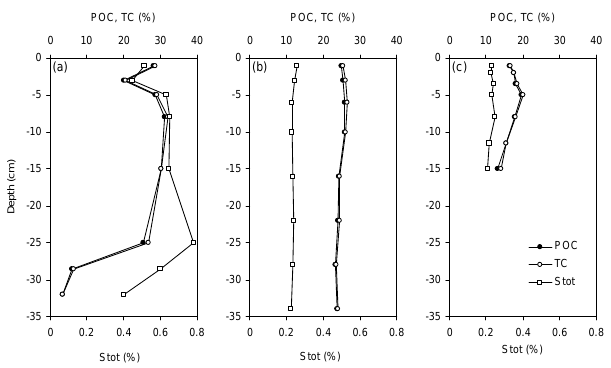
Fig. 3. Concentration-depth profiles of total carbon (TC) and sul- Figure 3 Audry et al. phur (Stot), and particulate organic carbon (POC) in the sediments of (a) Lake Shirokoe (3rd stage of the thermokarst life cycle), (b) Lake Yamsovey (4th stage), and (c) Lake Khasyrei (5th stage).